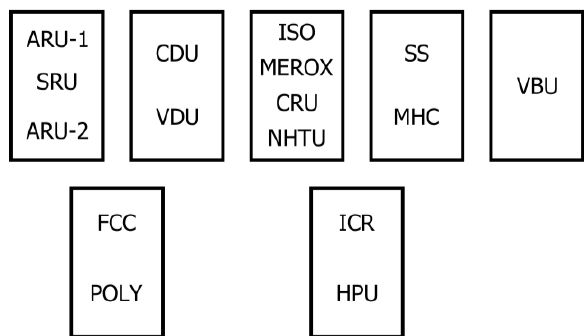
Figure 2. Basic refinery layout showing the 16 process units and the seven distinct process areas. ARU: amine recovery; SRU: sulphur recovery (including the TGTU: Tall Gas Treatment Unit); CDU: crude distillation; VDU: vacuum distillation; ISO: isomerization; MEROX: mercaptan oxidation; CRU: catalytic cracking reforming; NHTU: naphtha hydrotreating; SS: Synsat; MHC: mild hydro cracker; VBU: Visbreaker; FCC: fluid catalytic cracker; POLY: polymerisation; ICR: hydrocracking; HPU: hydrogen production.